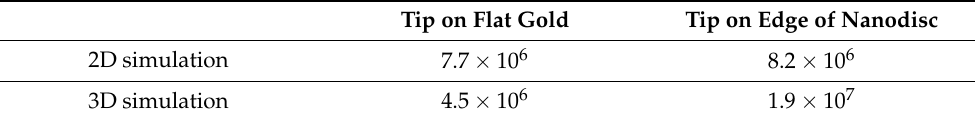
Table 1. Comparison on TERS EF between 2D and 3D simulation results for the two specific geometries representing the two experimental